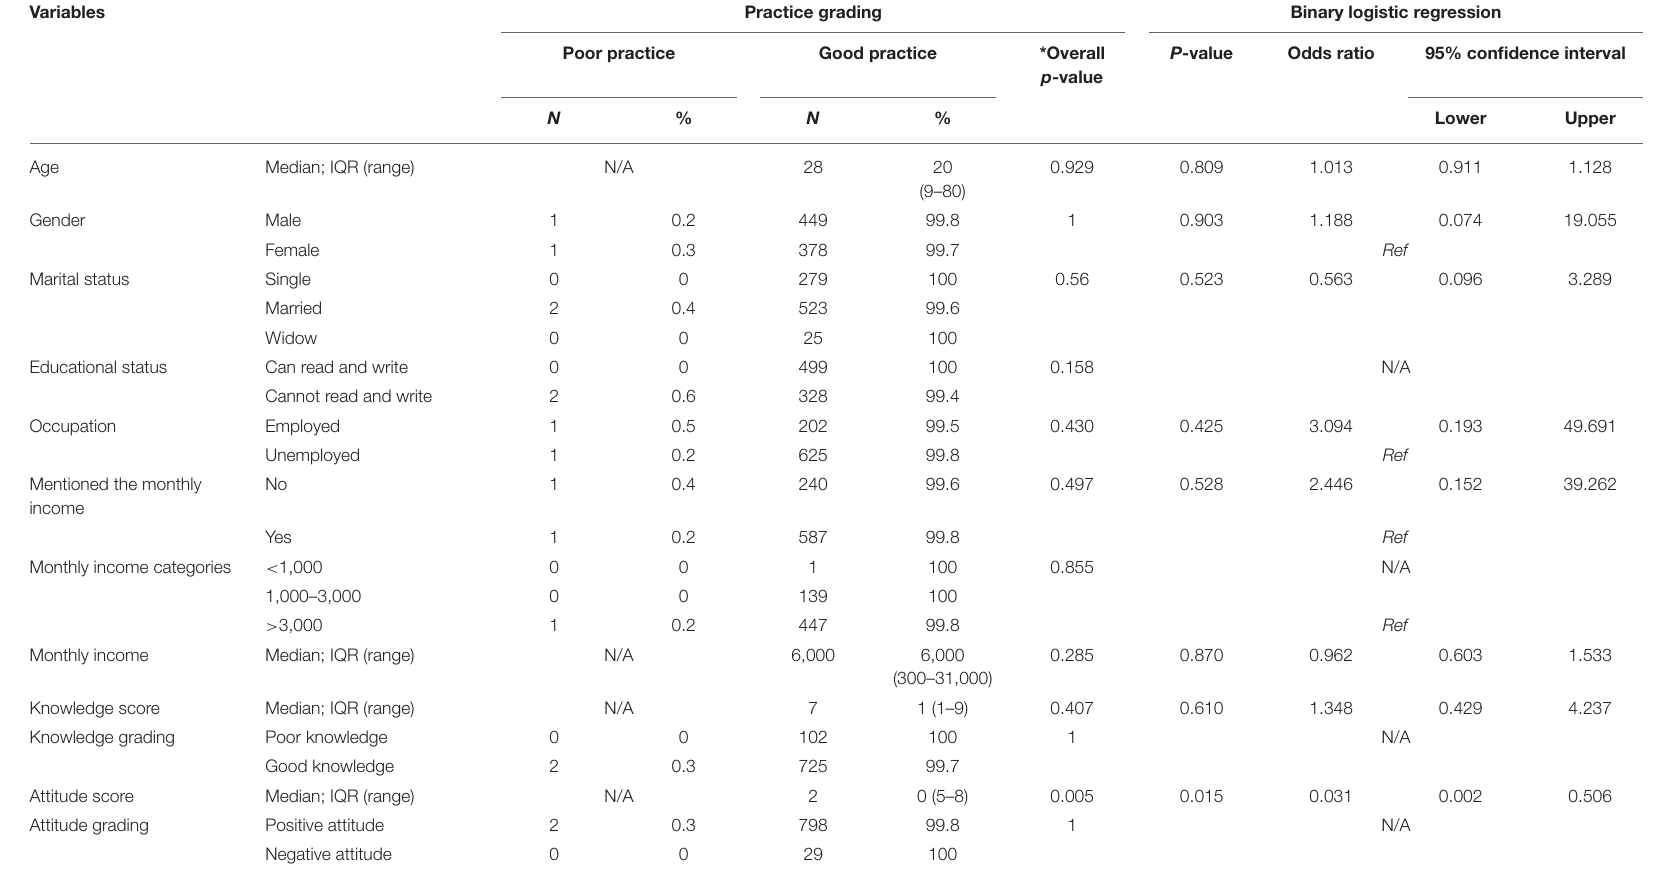
TABLE 5 | Practice and associated factors ( N = 829